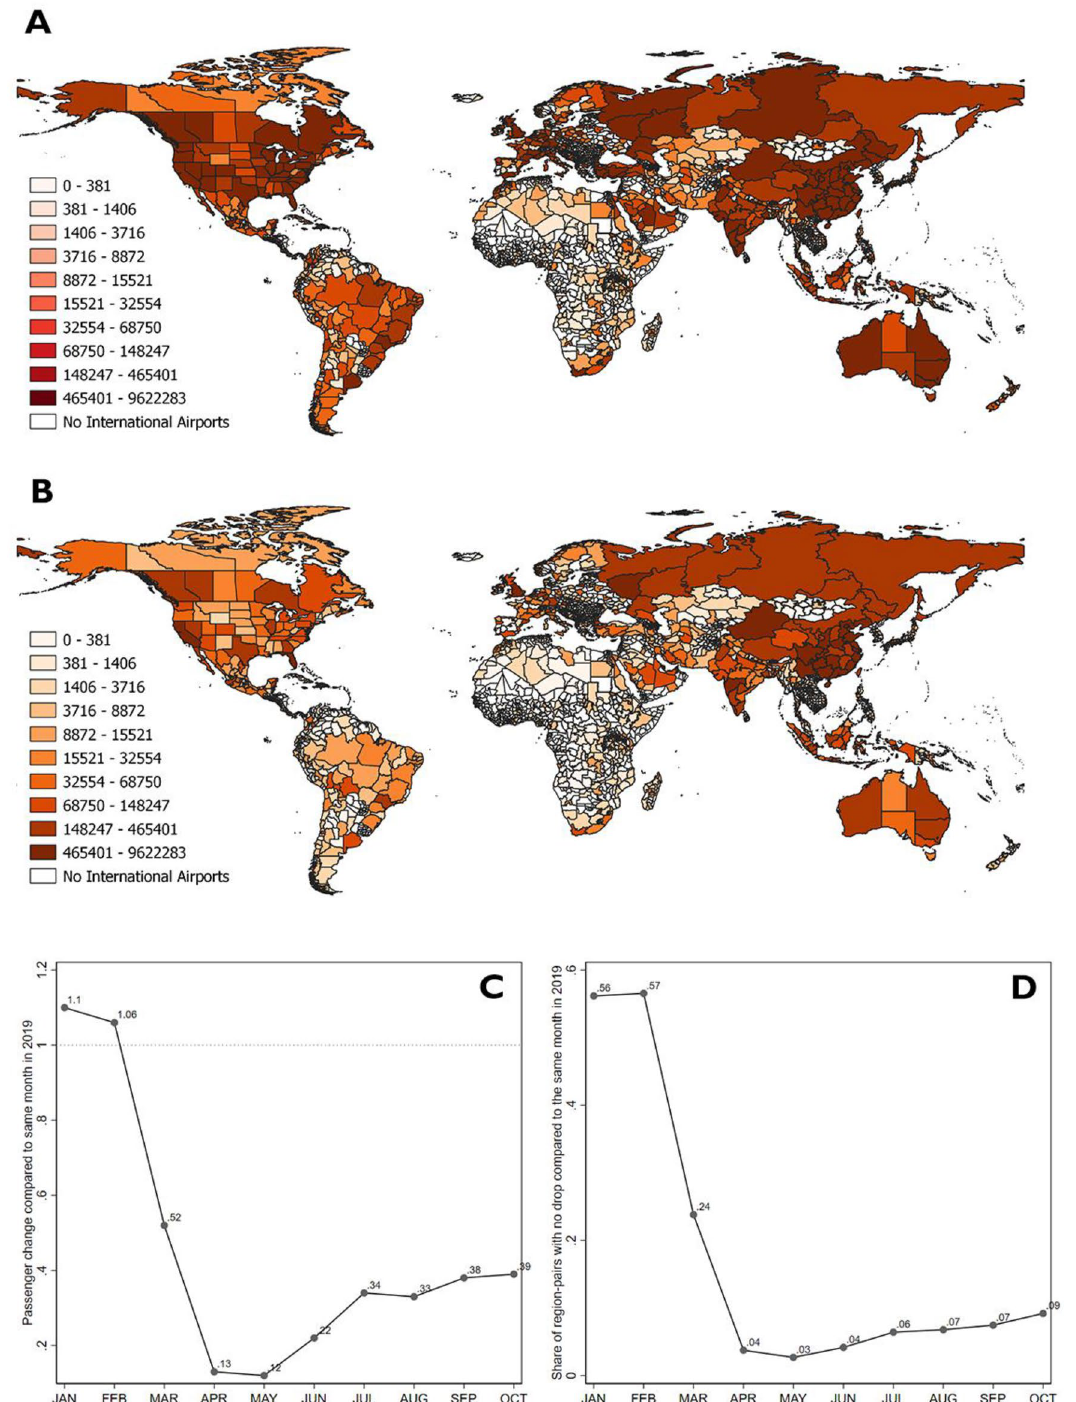
Figure 1. The drop in global air traffic induced by COVID-19. Panel ( A ) Shows the number of incoming passengers by subnational areas in April 2019; panel ( B ) shows the situation one year later in April 2020. Panel ( C ) shows the average change in the monthly number of air passengers in 2020 compared to 2019 (with a value smaller than 1 indicating a drop in passengers). Panel ( D ) shows the share of region-pairs that saw no drop in air passenger traffic in 2020 compared to the same month in 2019. A drop is defined here as the number of passengers reaching 90 per cent or less of the value in the previous year (assuming that a drop of less than 10 per cent is not meaningful and may simply indicate random fluctuation). Source : Sub-National COVID-19 Incidence and Determinants